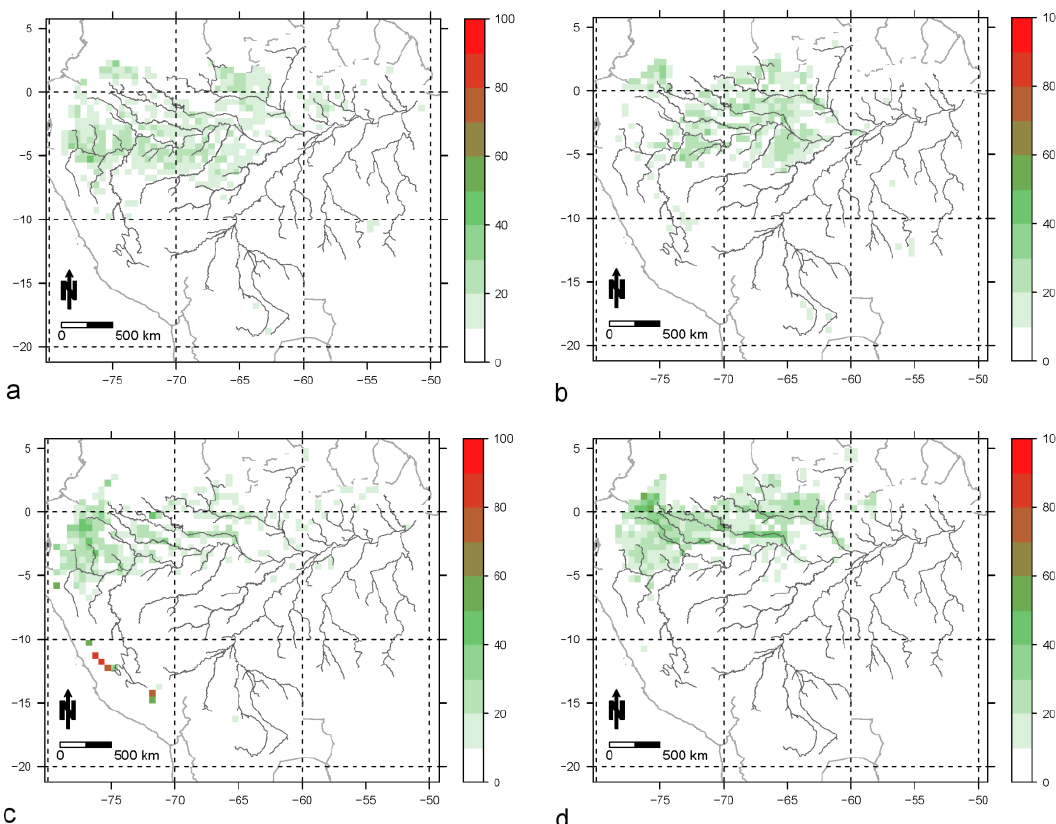
Fig. 8. Proportion of models in agreement [%] in a forward shift (a, c) and backward shift (b, d) between future and reference period of at Figure 8. Proportion of models in agreement [%] in a forward shift (a, c) and 853 least 3-months of high water peak month (a, b) and low water peak month (c, d) backward shift (b, d) between future and reference period of at least 3-months of high 854 water peak month (a, b) and low water peak month (c, d). 855